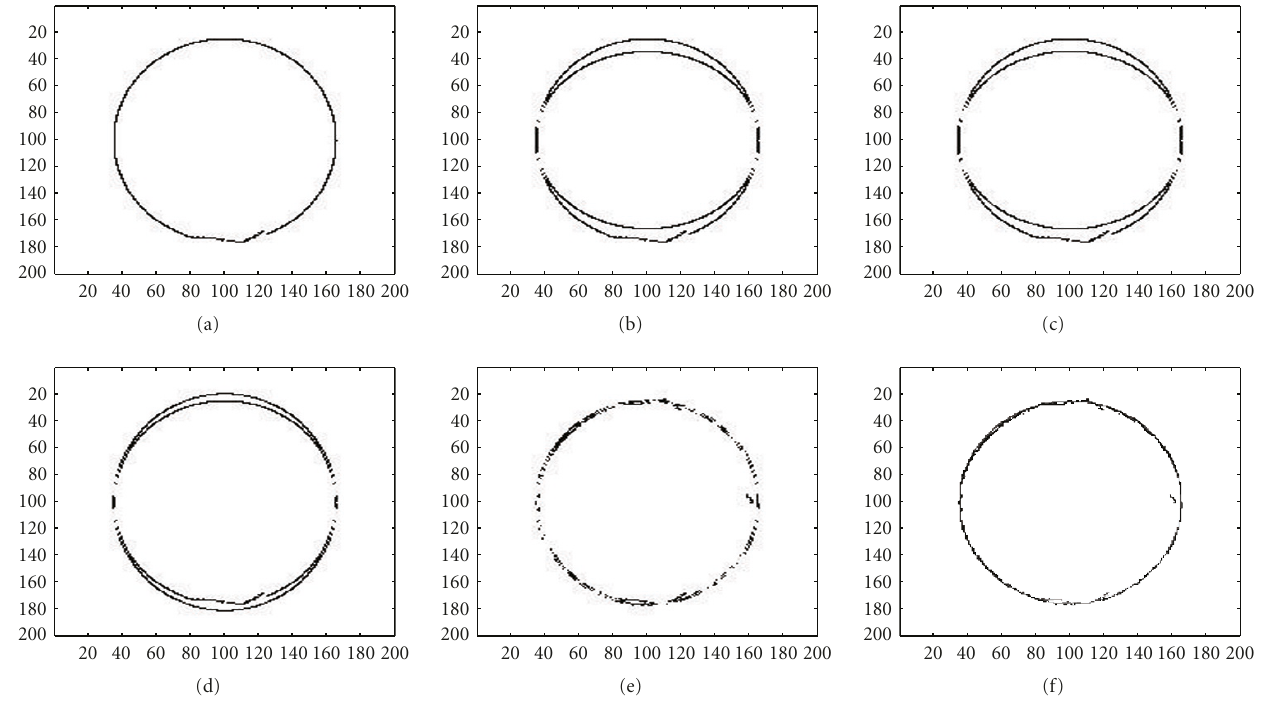
Figure 7: Ellipse fitting: (a) processed. (b) Di ff erence processed and result by the existing method for ellipse retrieval [6]. (c) Di ff erence processed and result by the GHT. (d) Di ff erence processed and result obtained after applying the proposed method: ME ρ = 2 . 8 pixel. (e) Di ff erence processed and result obtained after applying gradient method: ME ρ = 0 . 7 pixel. (f) Superposition processed and result obtained after applying gradient